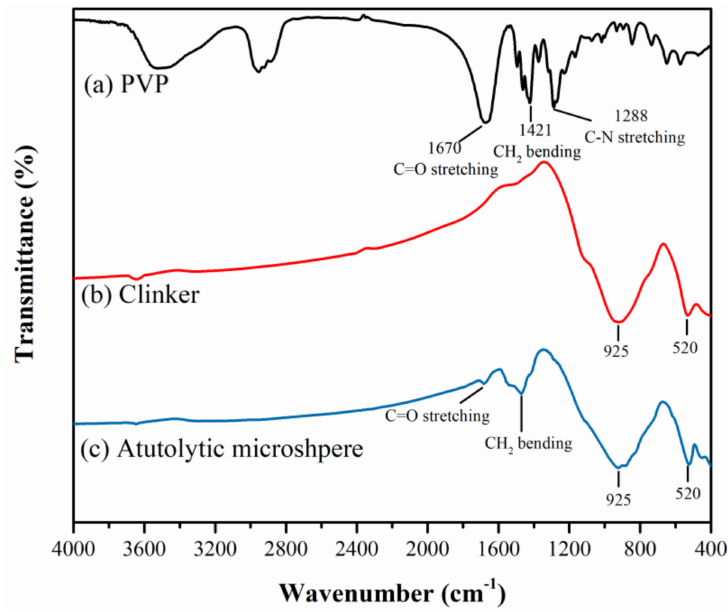
Figure 3. Fourier transform infrared spectroscopy (FTIR) spectra of ( a ) PVP (polyvinyl pyrrolidone), ( b ) clinker, ( c ) clinker / PVP autolytic